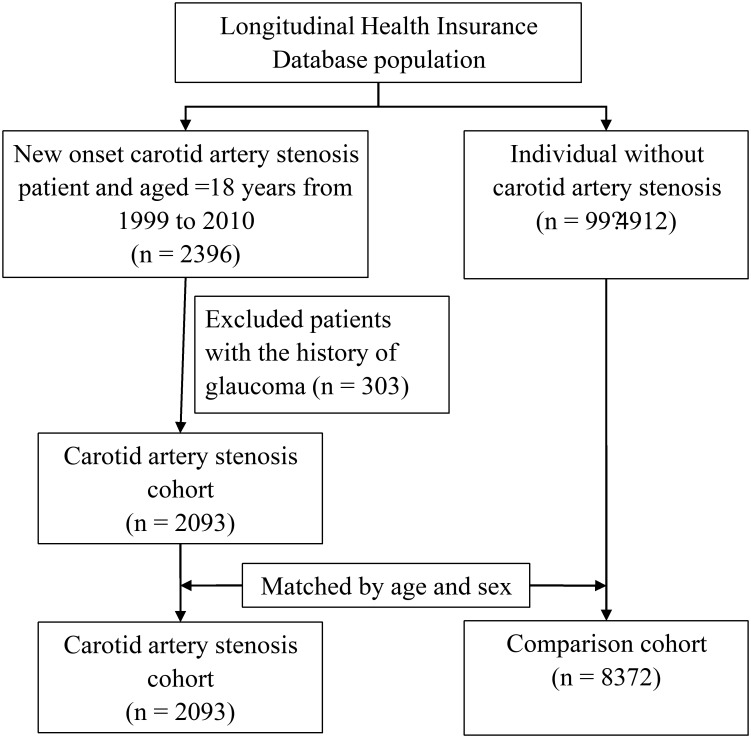
Flowchart of study population selection.